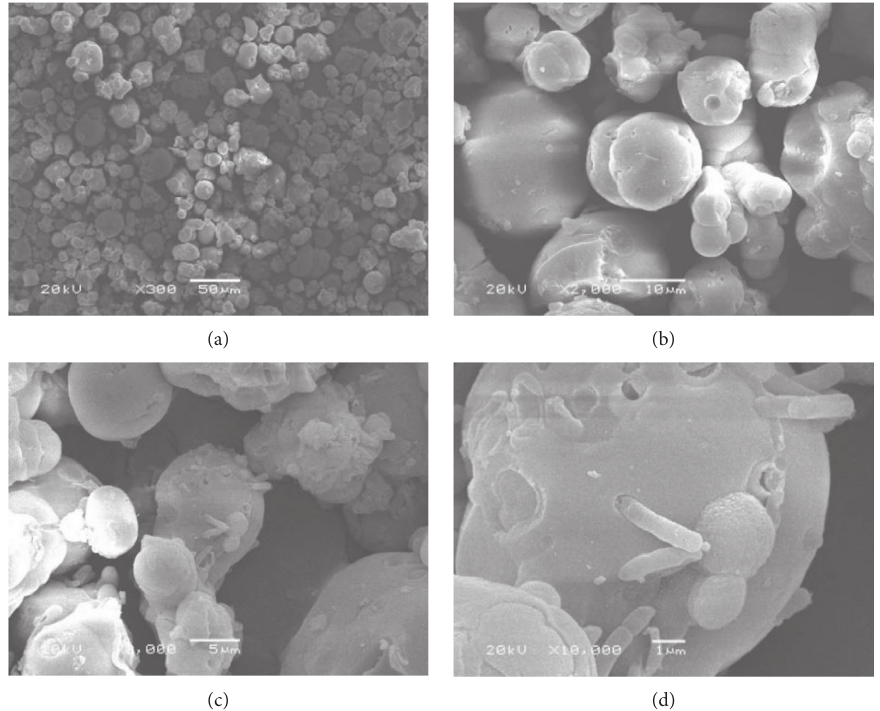
Figure 10: Microscopic morphology of calcium carbonate produced by